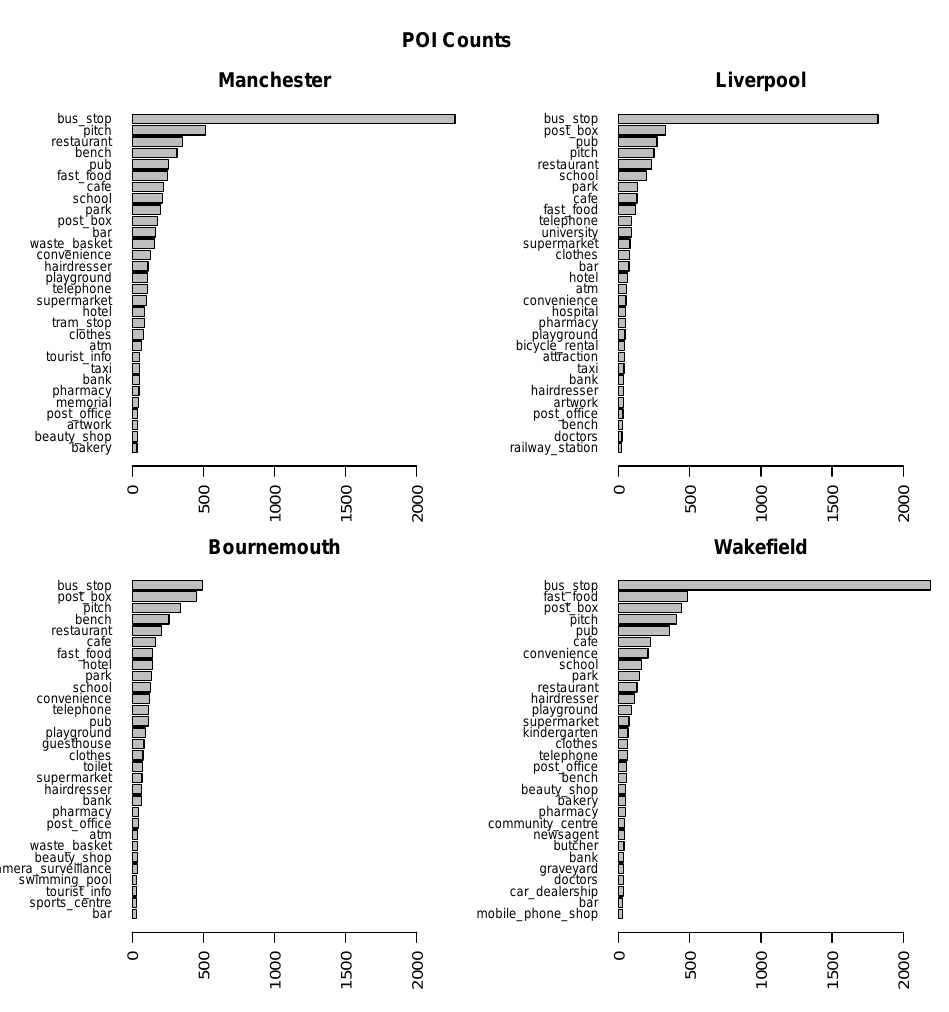
Figure 3. POI counts for the most frequent 30 categories within each urban